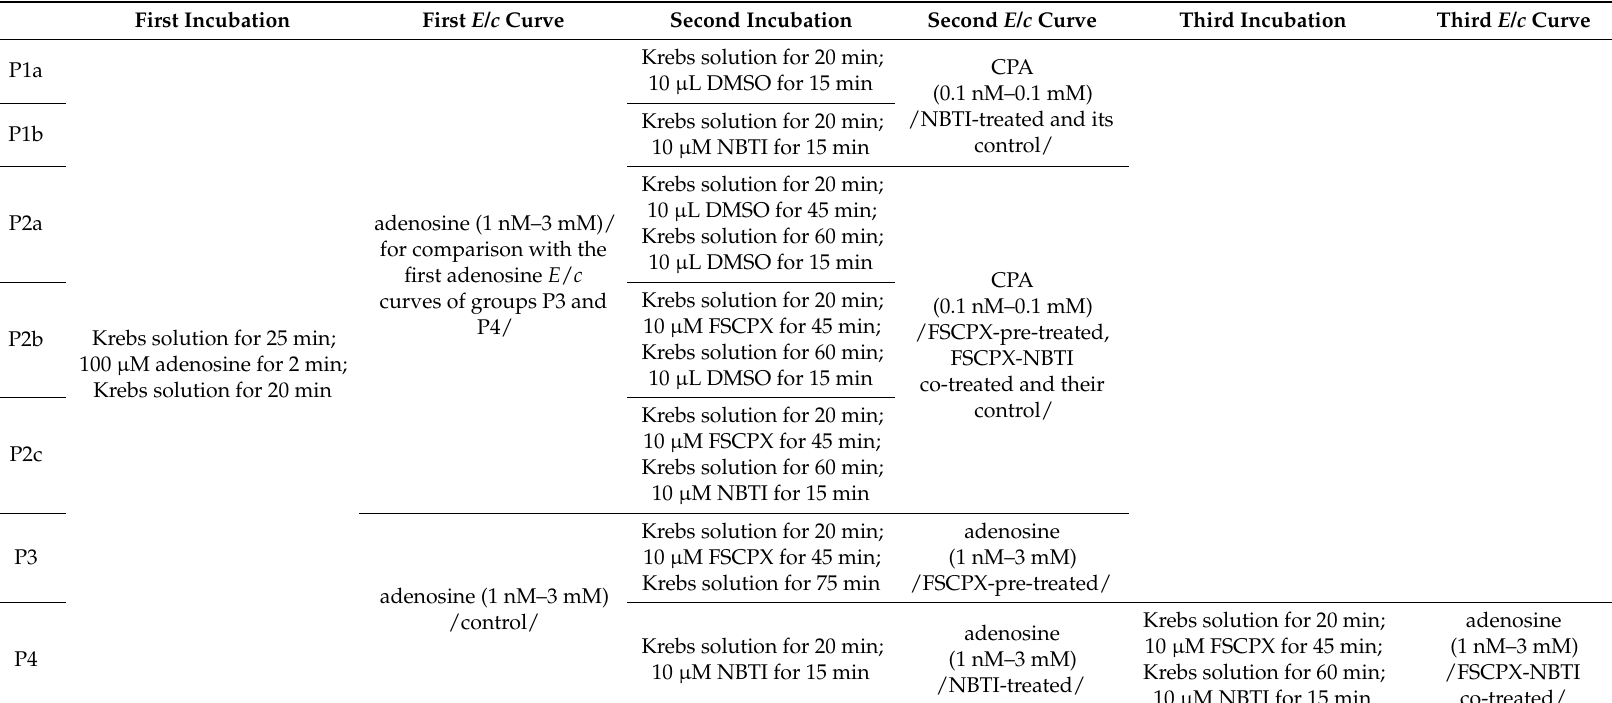
Table 1. The seven protocols forming seven groups /and the role of the concentration-response ( E / c )